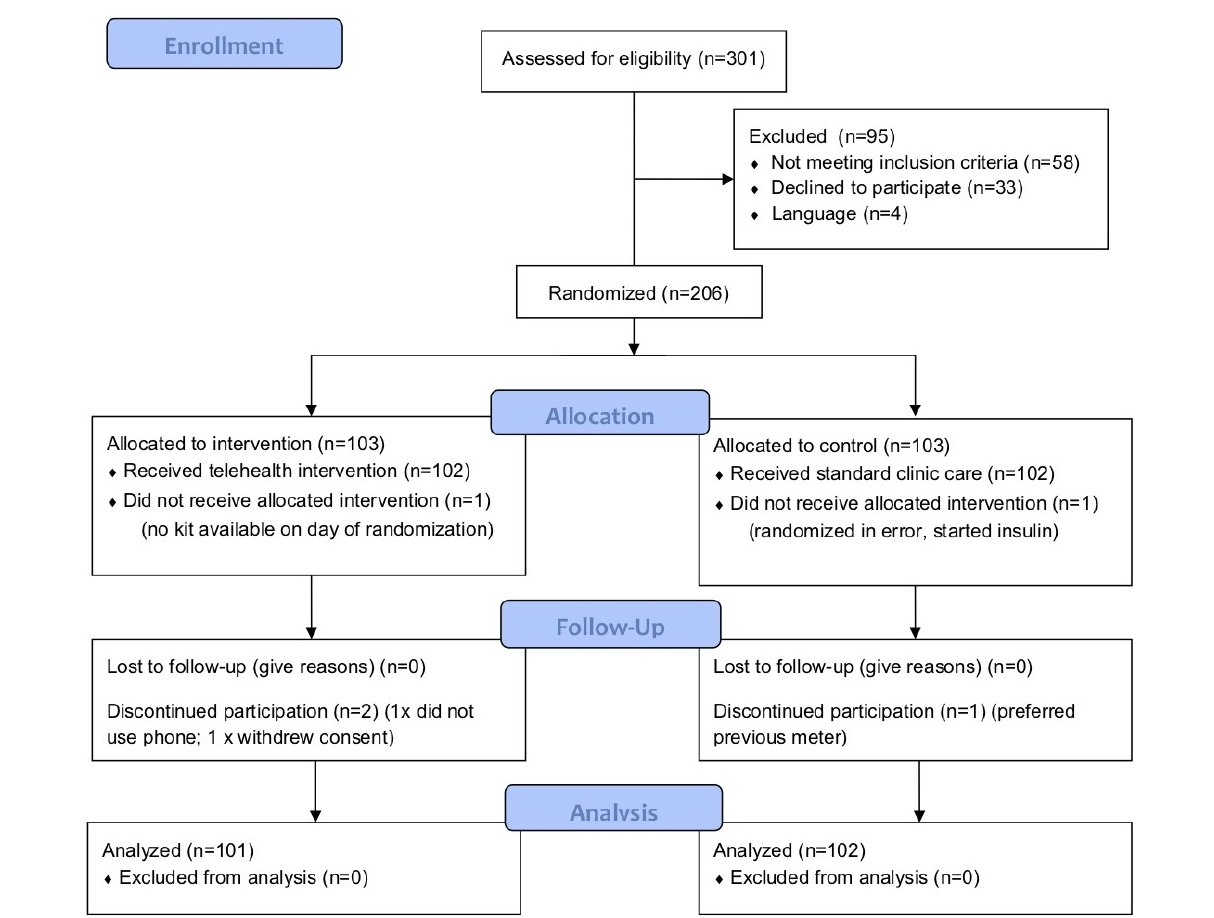
Figure 1. CONSORT Flow Diagram for TREAT